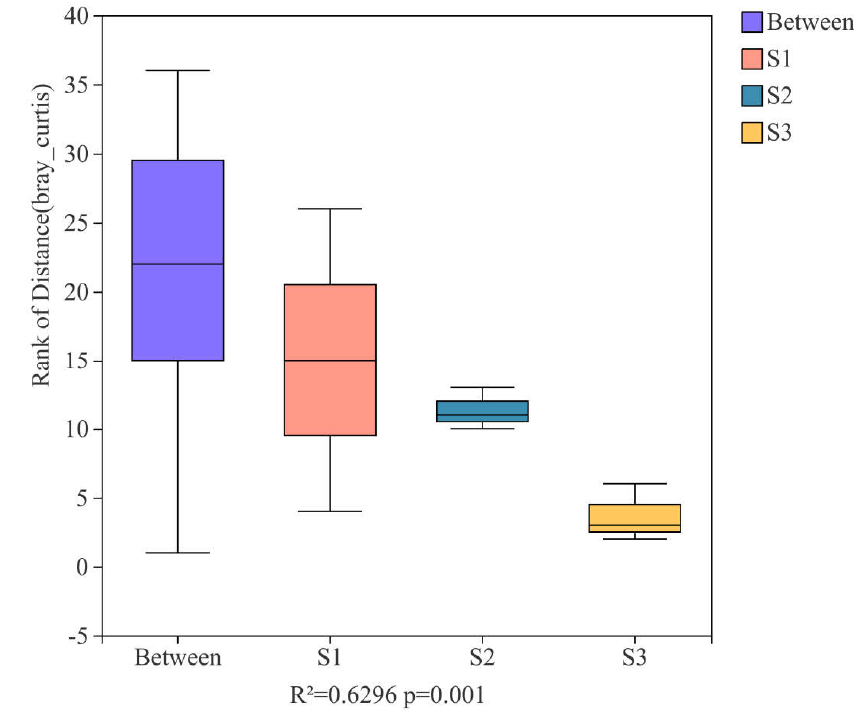
Figure 2. Anosim similarity among groups of samples.